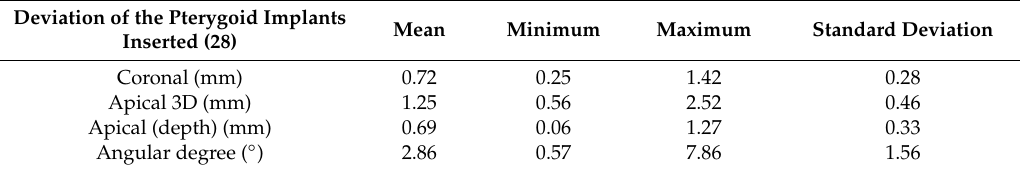
Table 2. Mean, maximum, and minimum of the coronal, apical 3D, apical vertical (depth), and angular deviations of the pterygoid implants inserted using a dynamic navigation system ( n = 28).